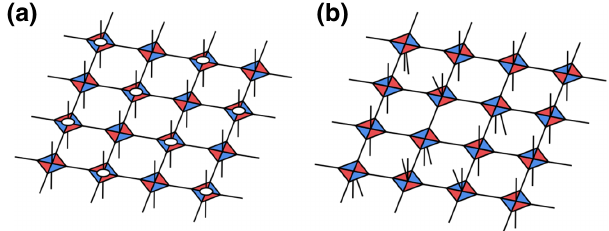
FIG. 9. Local patches of the full tensor network that describes a surface-code variant: (a) Tensors with a white circuit differ from the original tensor by a Hadamard acting on the down- ward pointing leg, this changes an all Z or all X stabilizer to the form of XZZX as needed. All other interpretations of the network remains unchanged. (b) We choose, nonuniformly, to have some legs (upward pointing) to be logical and some legs (downward pointing) to be